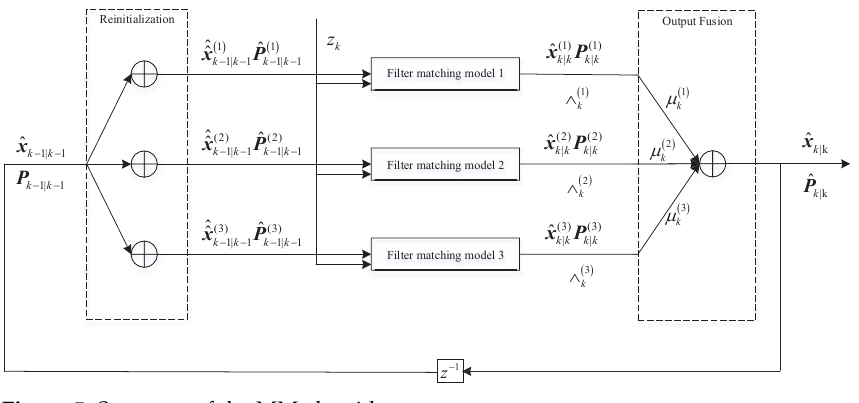
Figure 5. Structure of the MM